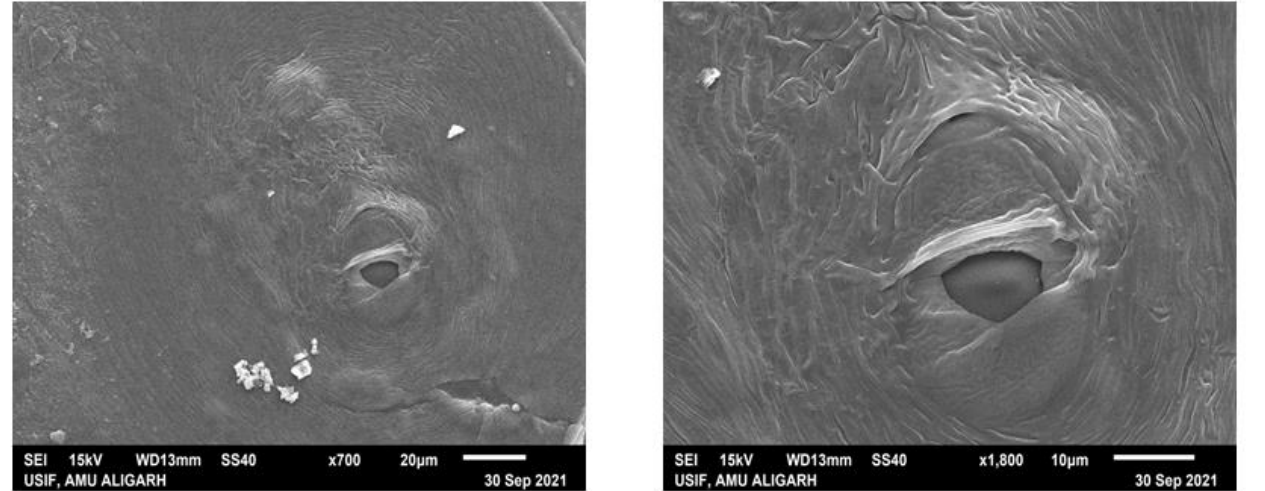
Figure 3. SEM micrograph of perineal pattern of Meloidogyne incognita at different